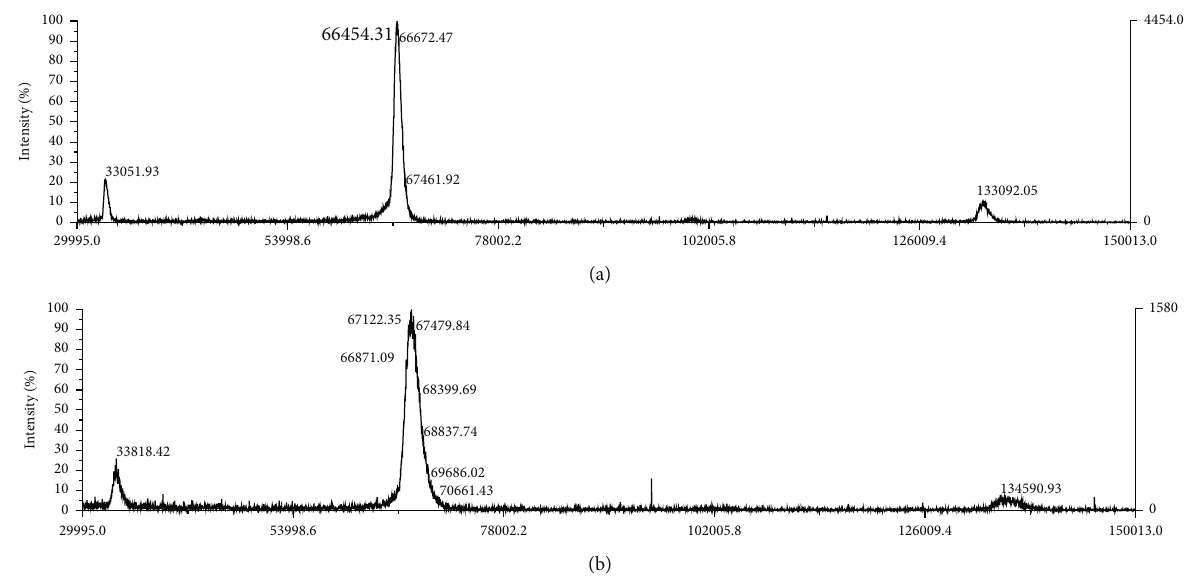
Figure 3: MALDI-TOF mass spectra of (a) native HSA and (b) the CT – HSA conjugate.